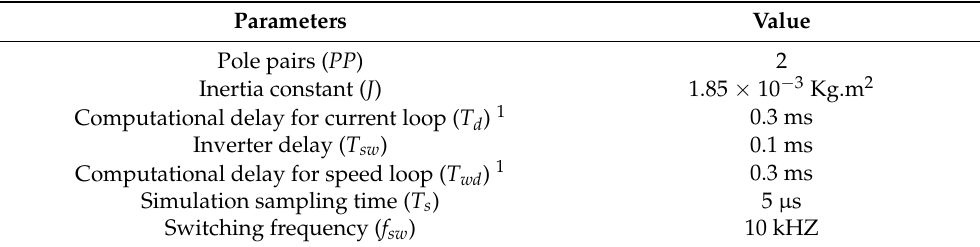
Table 3. Simulation model parameters for the speed control of a SynRM.